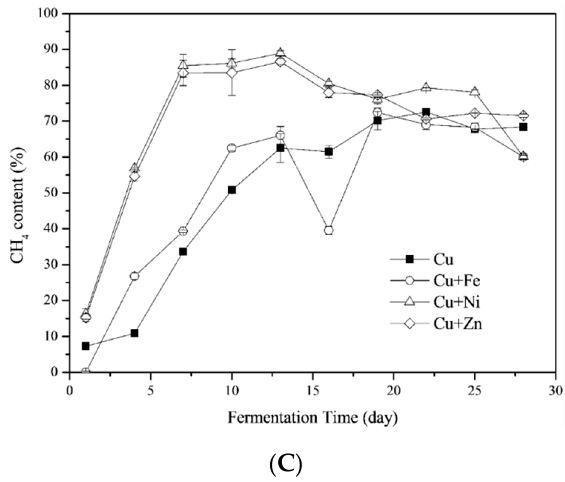
Figure 1. Cumulative biogas yields ( A ); daily biogas yields ( B ); and CH 4 contents ( C ) during the fermentation process with combination of Cu and Fe, Ni and Zn.